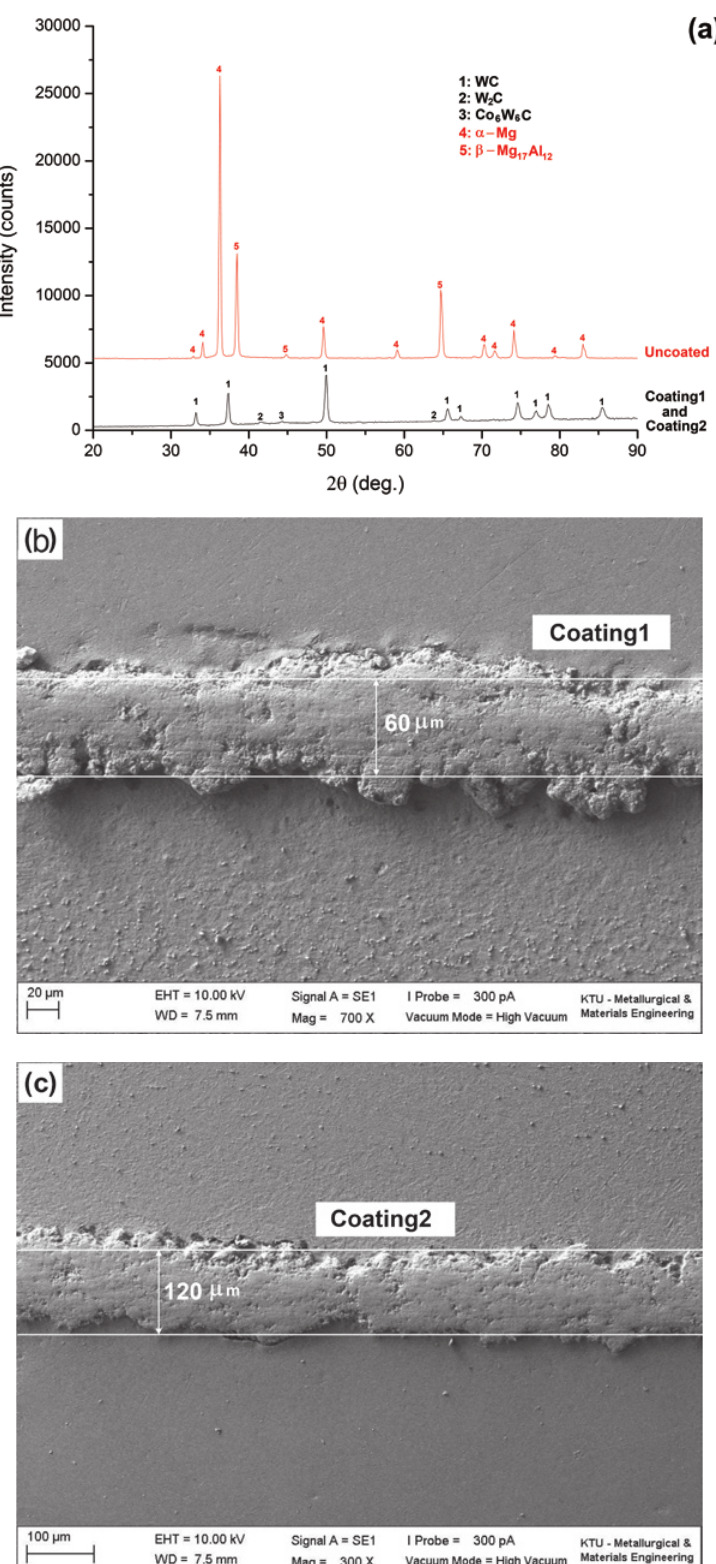
Fig. 2: XRD analysis results: (a) the cross-sectional SEM images, (b) Coating1, (c)